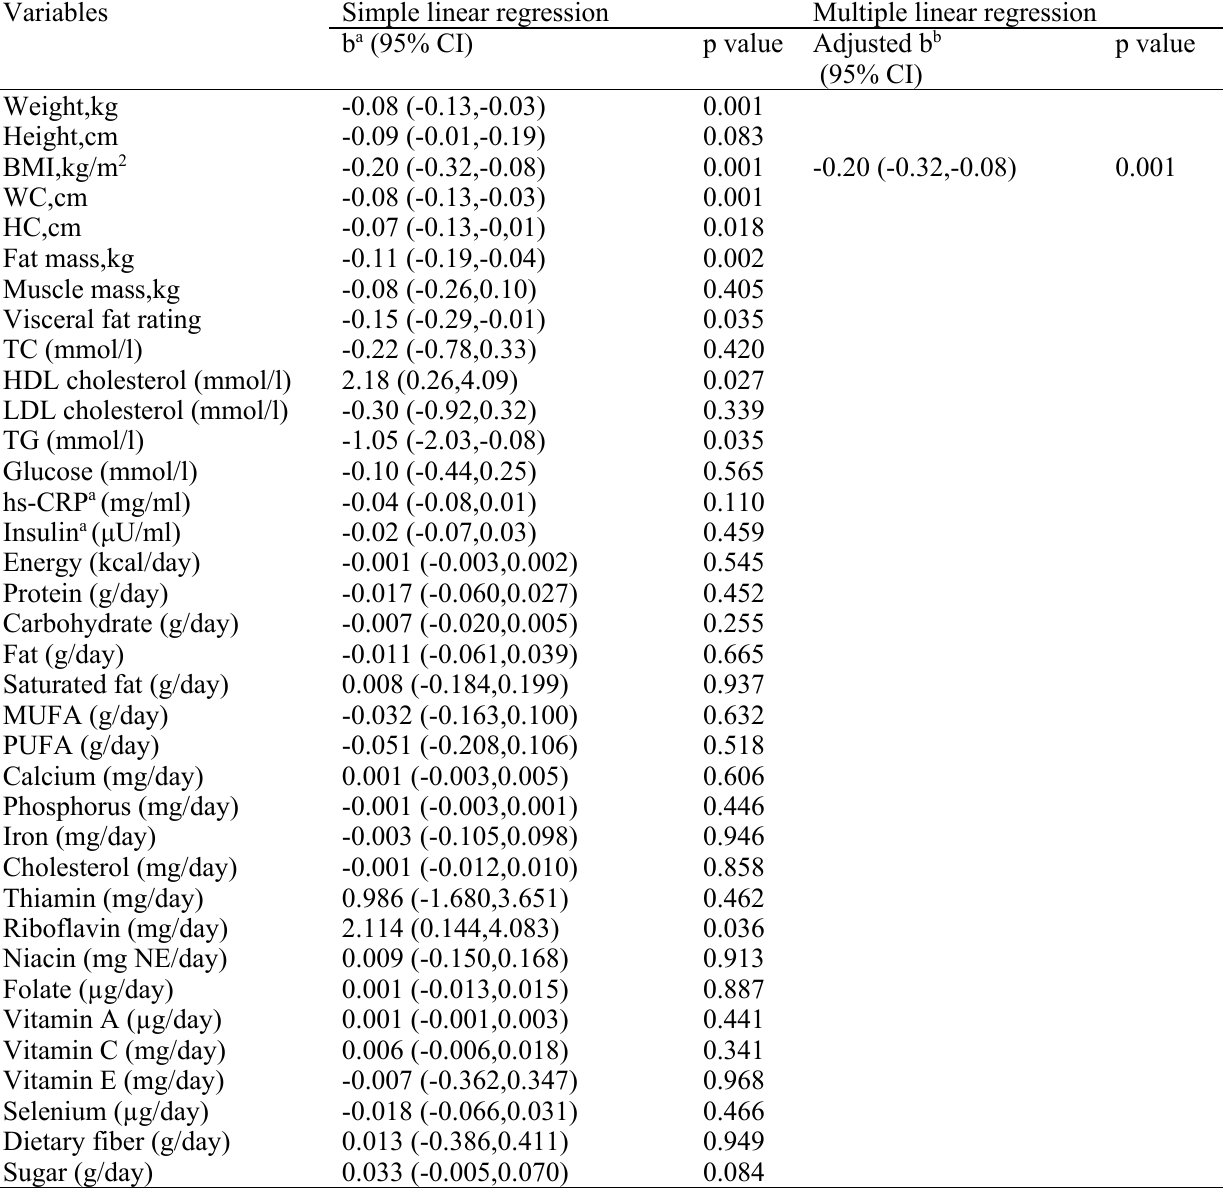
Table 3 Associations of nutritional status with HMW adiponectin among healthy controls Variables Simple linear